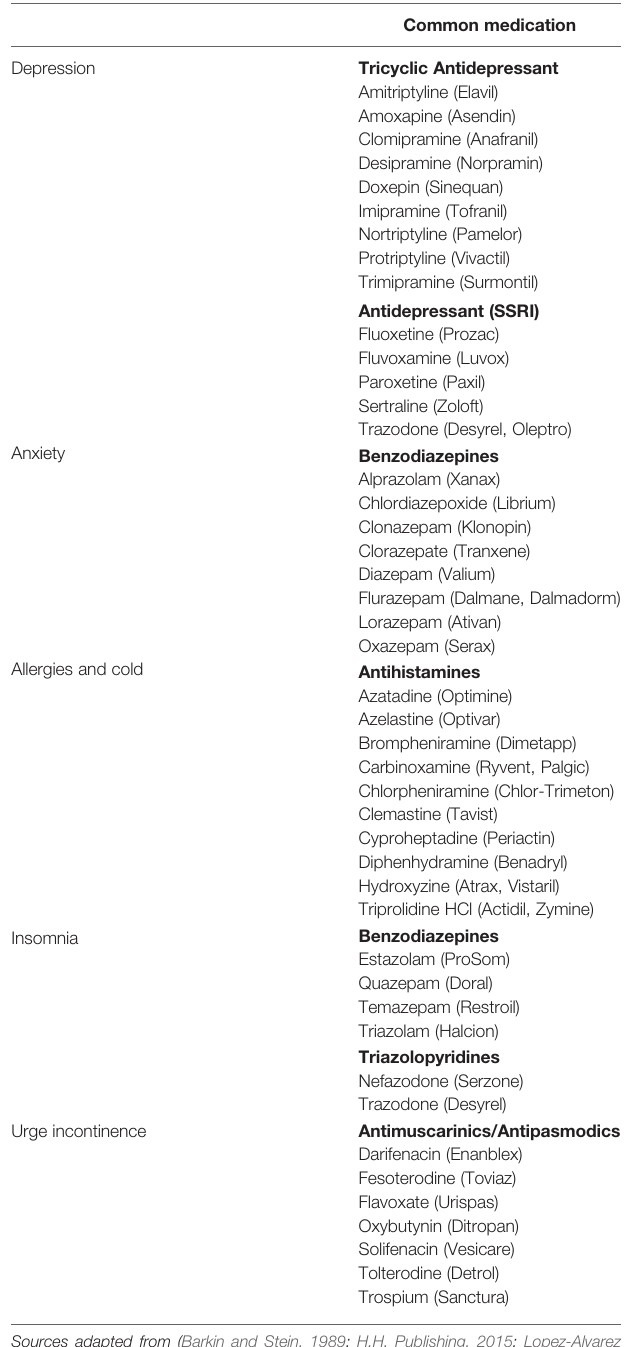
TABLE 1 | Some common medication with anticholinergic